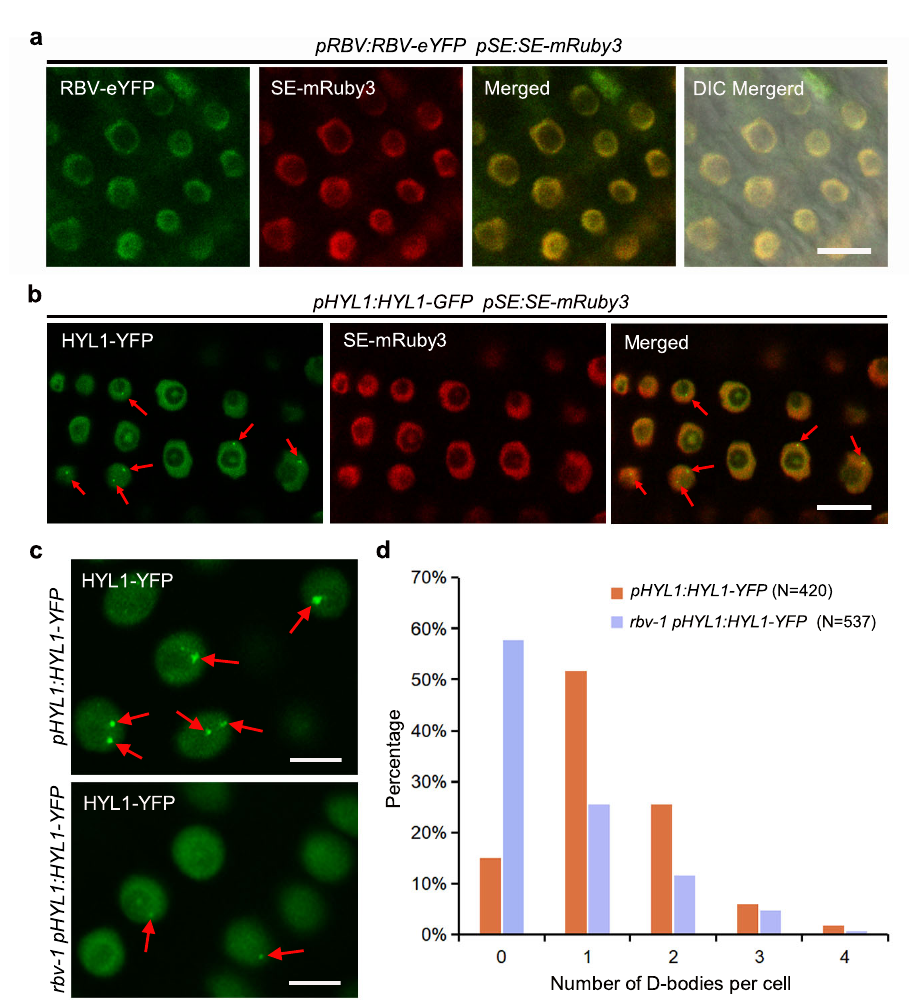
Fig. 4 RBV is required for the proper localization of HYL1 in D-bodies. a RBV is localized in the nucleoplasm. eYFP and mRuby3 signals were detected in root cells ( n = 100) from pRBV:RBV-eYFP pSE:SE-mRuby3 transgenic plants. Bar = 10 μ m. b HYL1 and SE protein localization in roots of pHYL1:HYL1-YFP pSE:SE-mRuby3 plants. Both proteins show nucleoplasmic localization while HYL1 also shows D-body localization. In total 100 cells were observed. Bar = 10 μ m. c Representative images of pHYL1:HYL1-YFP signals in root cells from the meristematic zone in the two genotypes. Arrows indicate D-bodies. Bars = 5 μ m. d The percentage of cells with 1 – 4 D-bodies per cell in wild type and rbv-1 . The x -axis represents the number of D-bodies per cell, and the y - axis represents the percentage of cells with the corresponding number of D-bodies. “ N ” means the numbers of total root cells examined. Source data are provided as a Source Data fi